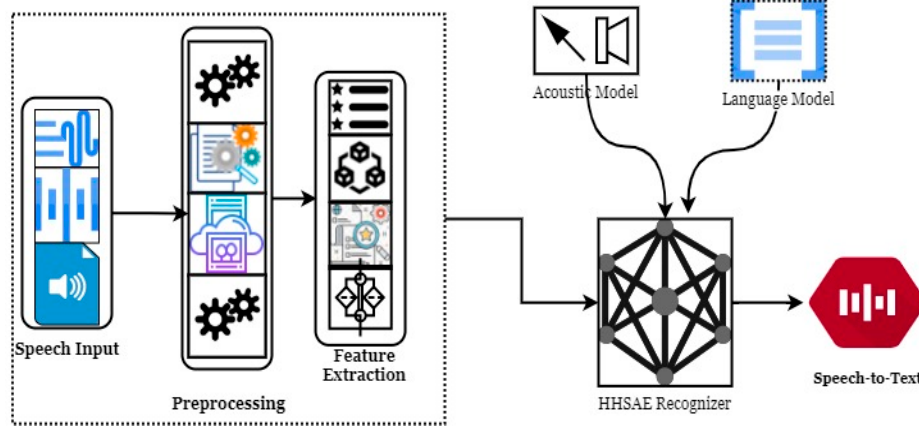
Figure 1. Outline of HHASE-ASR framework that includes speech input, speech preprocessing, fea- ture extraction, speech recognition, and speech-to-text modules. feature extraction, speech recognition, and speech-to-text